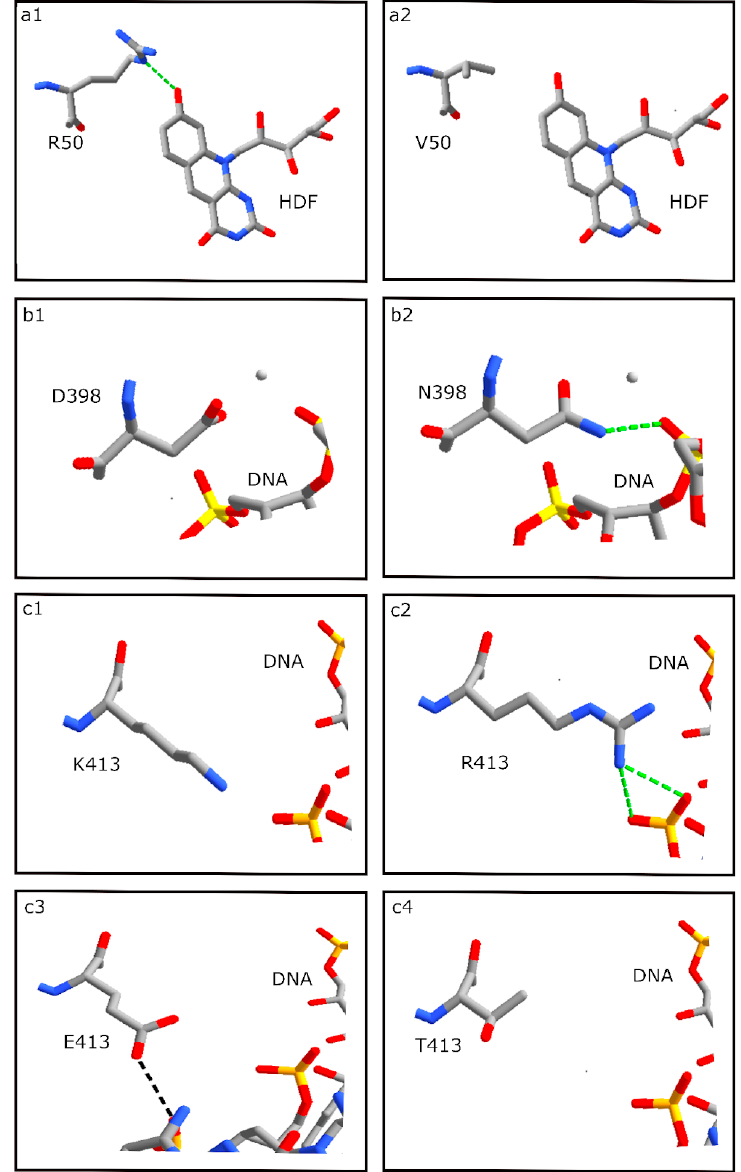
Figure 6. Analysis using Swiss-Pdb Viewer of interactions of natural or substituted amino acids at positions 50, 398 and 413 in the SEL photolyase with HFD cofactor or bound DNA. ( a1 ) R50 in SEL photolyase showing an H-bond with HDF; ( a2 ) R50V substitution in BOL5-1 showing no H-bond formation between V and HDF; ( b1 ) D398 in SEL photolyase shows no H-bond; ( b2 ) D398N substitution in BOL5-1 showing H-bond formation between N and DNA. Mg 2+ ion is shown as a gray sphere; ( c1 ) K413 in SEL photolyase showing no H-bond formation with DNA, FAD or HDF; ( c2 ) K413R substitution in NRC-1 showing two weaker H-bonds (black dashed lines) formation between R and DNA; ( c3 ) K413E substitution in BOL6-1 showing a weak H-bond formation between E and DNA; ( c4 ) K413T substitution in BOL5-1 showing no H-bond formation between T and DNA. Green dashed lines indicate stronger H-bonds in panels ( a1 , b2 , c2 ), and the black dashed line indicates a weaker H-bond in panel ( c3